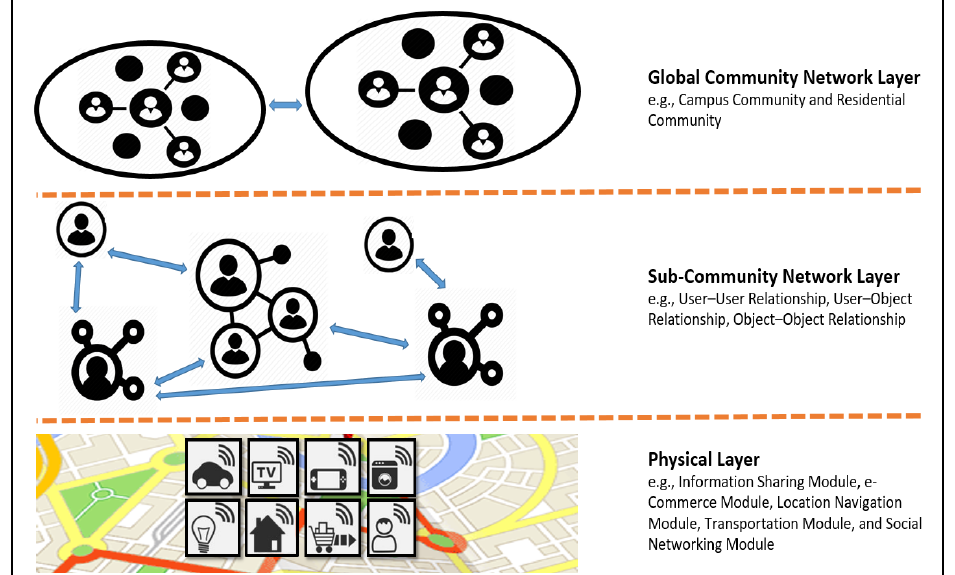
Figure 6. SIoT community model.